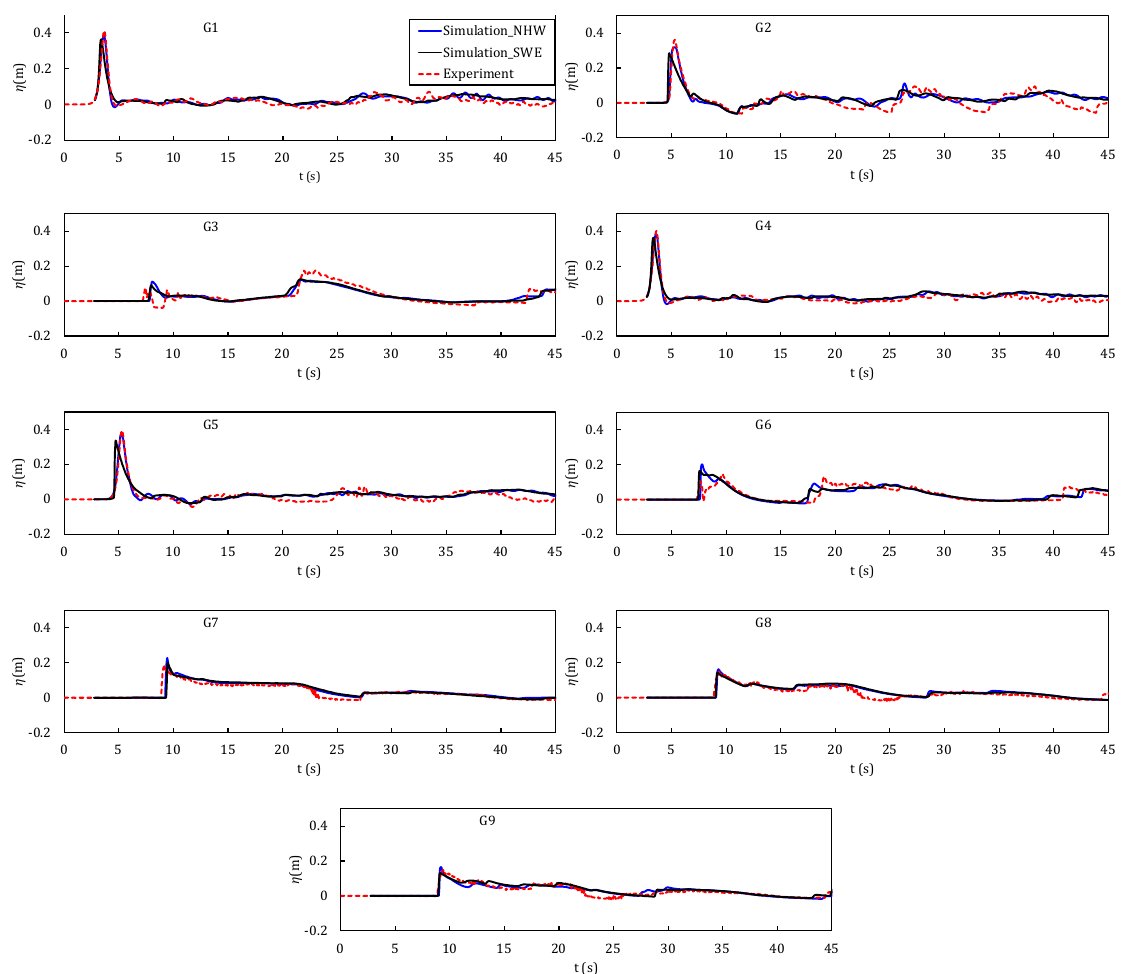
Figure 16. Comparisons of temporal water level fluctuations at different gauge